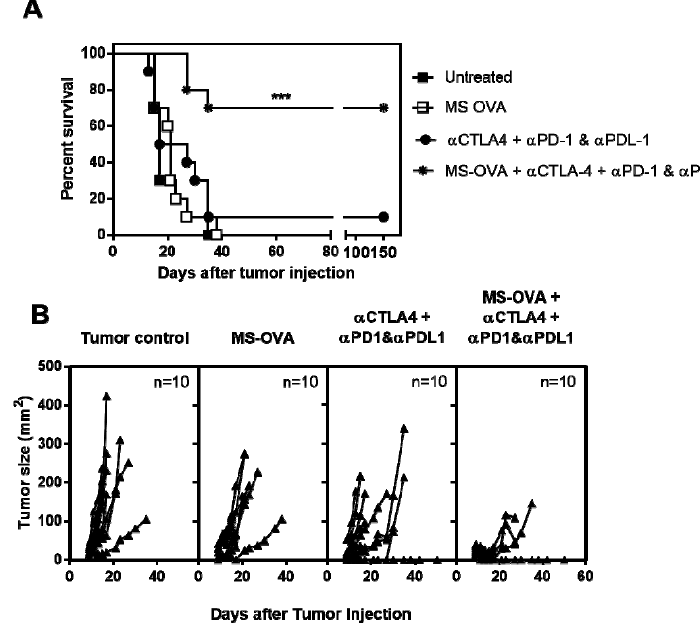
Figure 6. MS-OVA therapy in combination with checkpoint inhibitor therapy significantly improves survival outcome. C57BL/6 mice were given 5 × 10 5 B16-OVA tumor cells s.c. in the dorsal flank; 3, 8, and 18 days later 20 μ g MS-OVA was injected s.c. at the base of the tail away from the tumor site. In total 100 μ g α CTLA-4 (Clone 9D9) was given s.c. alongside the archaeosome vaccination. Then, 250 μ g each of α PD-1 (clone: RMP1-14) and α PD-L1 (clone: 10F.9G2) was given i.p on days 9, 12, 15, and 18. Log-rank Mantel Cox test, *** p < 0.001. This study was repeated to confirm results.